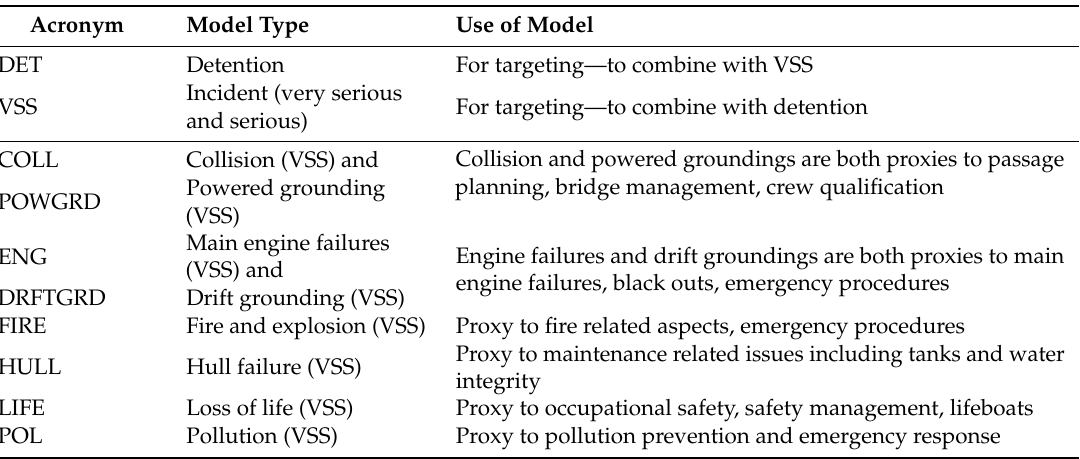
Table 2. Models chosen for this analysis and their related risk priority inspection